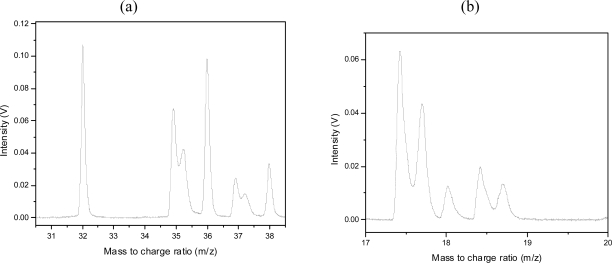
(a) Peak splitting of the 35Cl+ and 37Cl+ peaks but not the HCl+ peaks or the O2+ peak. (b) Peak splitting around mass 18. These are the 35Cl2+, H2O+ and 37Cl2+ peaks.